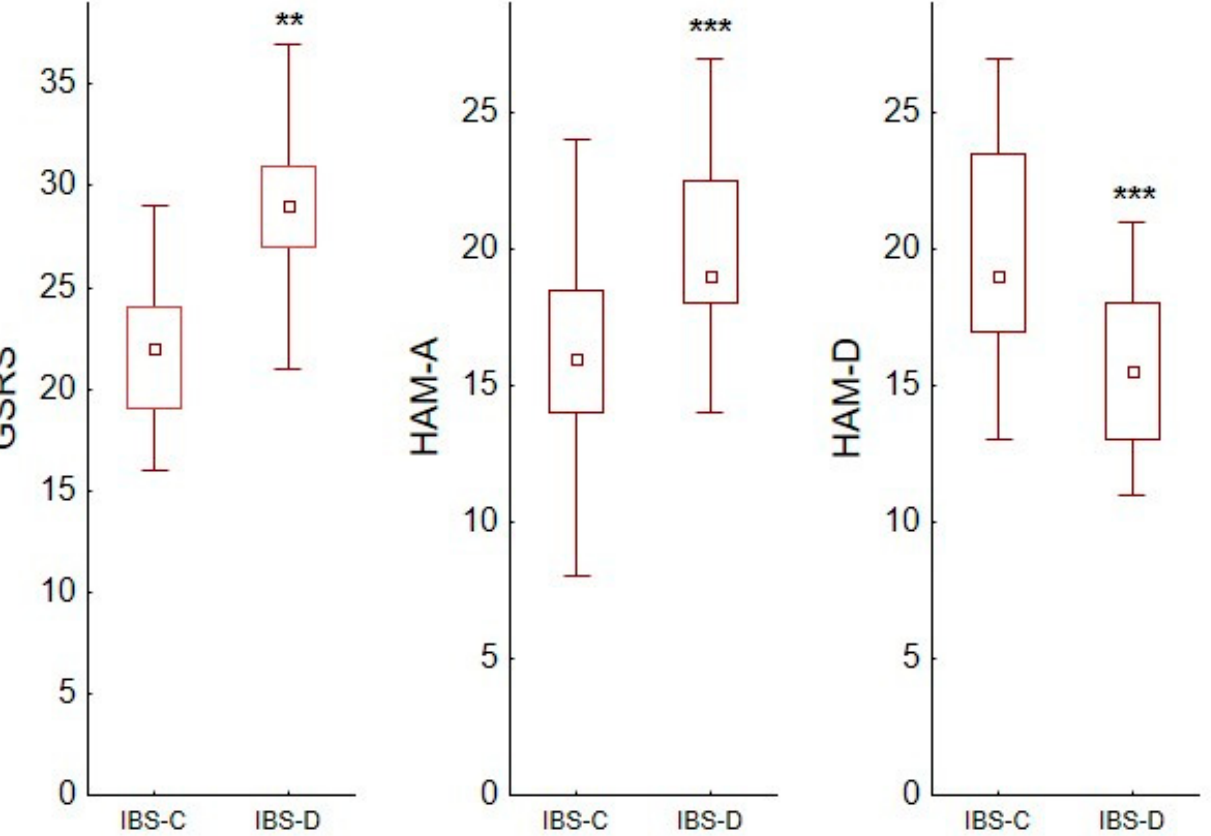
Figure 1. The score (points) of the Hamilton Anxiety Rating Scale (HAM-A) and the Hamilton Depression Rating Scale (HAM-D) in patients with constipation-predominant (IBS-C) and diarrhoea- predominant (IBS-D) irritable bowel syndrome; ** p < 0.01; *** p < 0.001. Box and whiskers represent median, IQR and min–max value.